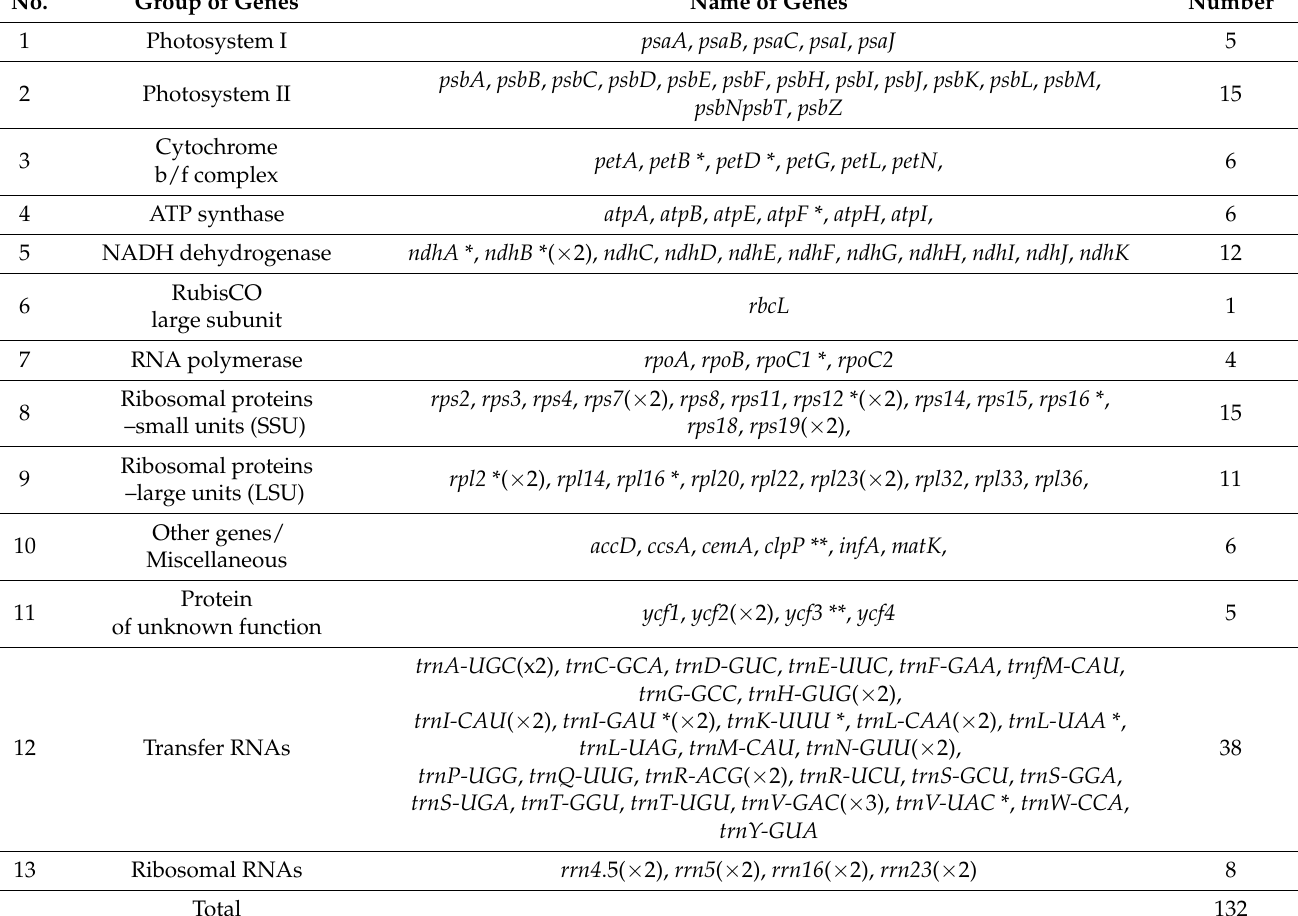
Table 2. List of genes present in the D. cinnabari chloroplast